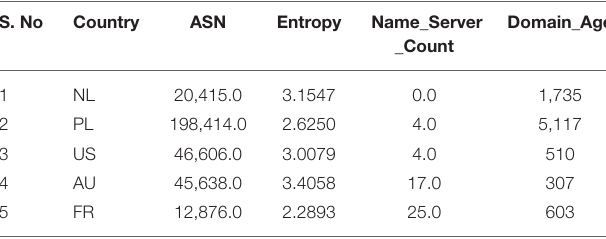
TABLE 3 | Example features in CIC Bell DNS 2021